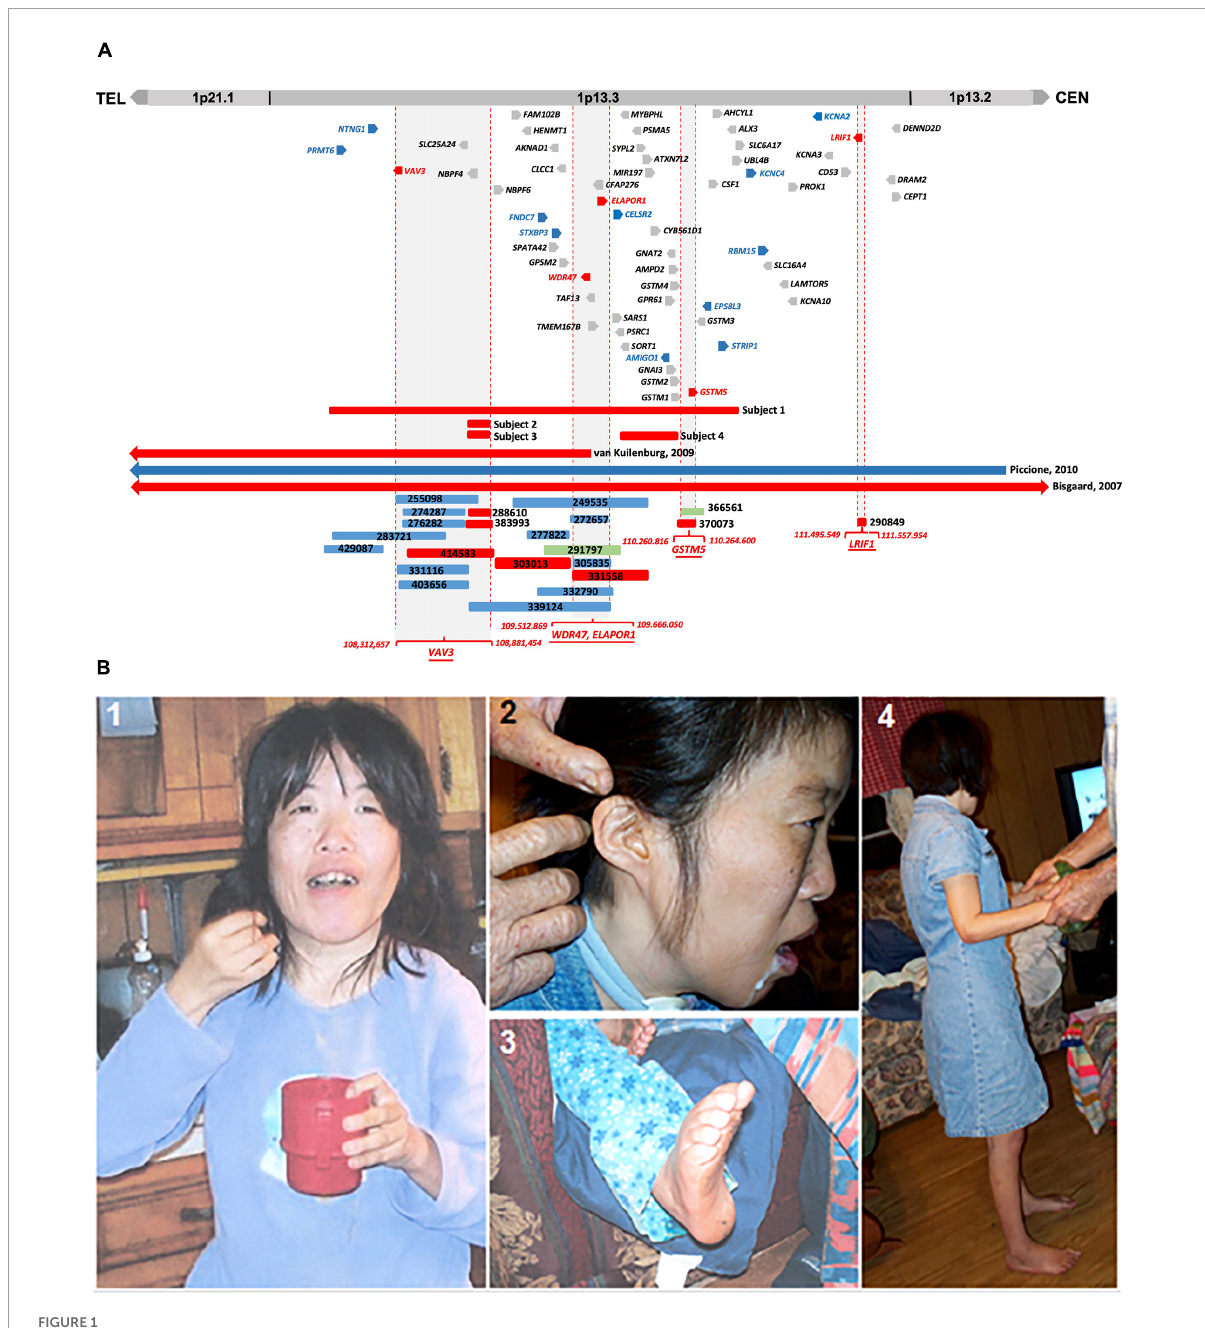
FIGURE1 (A) Comparative CNV mapping of subjects with CNVs at 1p13.3. Deletions are represented by red bars and duplications are represented by blue bars. CNV cases from the DECIPHER database are denoted by a six-digit reference number. The sizes of the deleted and duplicated regions from Bisgaard et al. (2007) (Case 1), van Kuilenburg et al. (2009) (Case 2), Piccione et al. (2010) (Case 3), and 22 DECIPHER cases are presented relative to our four subjects. Vertical dotted red lines flanking gray background represent the refined four candidate gene loci; 59 genes located within the 4.6 Mb genomic region at 1p13.3 are depicted either in red for positional candidate genes, blue for functional candidate genes, or gray for the remaining genes. (B) Phenotypic features of Subject 1. (1) Picture shows facial dysmorphism, asymmetrical head, and small hands; (2) Low set, small, and unfolded ears; (3) arched feet; and (4) full body picture showing short